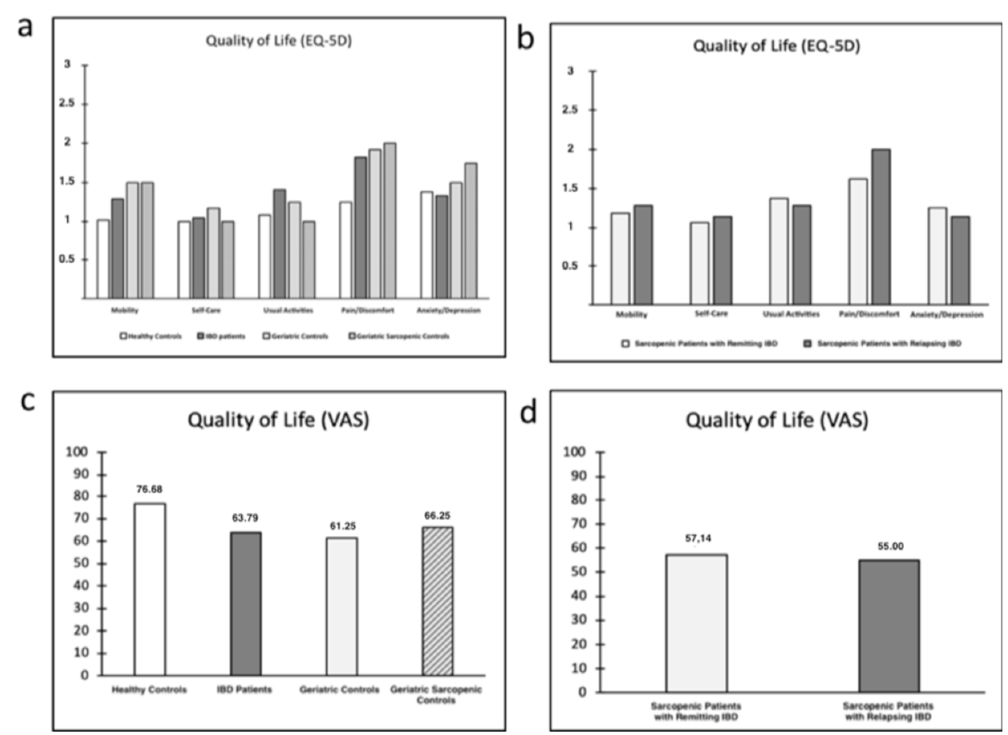
Figure 2. Sarcopenia and quality of life: ( a ) EQ-5D—study population; ( b ) EQ-5D—sarcopenic